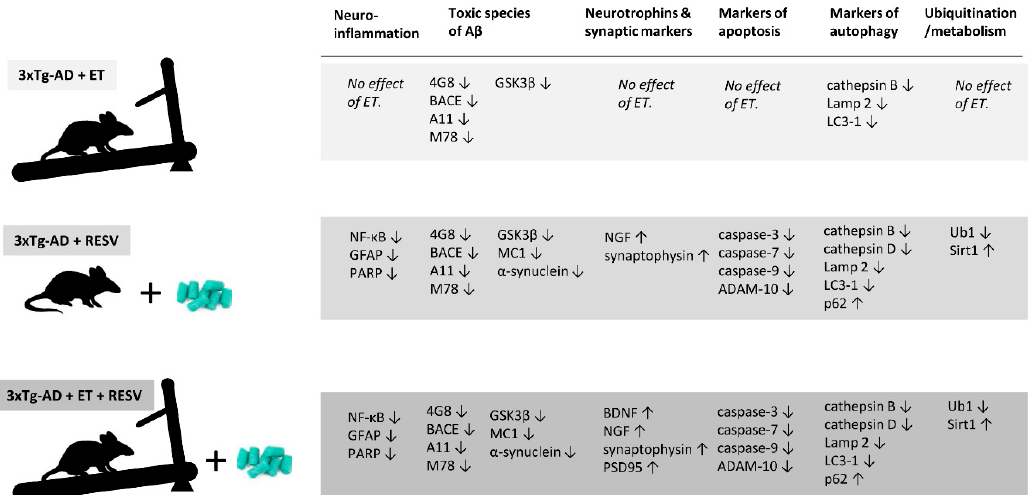
Figure 8. The effects of Resv and ET on protein expression of SIRT1 and AMPK. Representative immunoblots show a significant decrease in the expression level of SIRT1 in 3xTg-AD mice. Treatment with Resv or Resv with ET increased the expression SIRT1. Expression levels of AMPK were not significantly different between groups. Corresponding densitometry measurements: A, WT mice; B, 3xTg-AD mice; C, 3xTg-AD mice + ET; D, 3xTg-AD mice + Resv; E, 3xTg-AD mice + Resv + ET. SIRT1, silent information regulator 1; AMPK, AMP-activated protein kinase. AD, Alzheimer’s disease; ET, exercise training; Resv, resveratrol. Data presented as mean ± SEM for 3 mice per group. *, compared to WT mice, p < 0.05; † , compared to 3xTg-AD mice, p < 0.05; ‡ , compared to 3xTg-AD mice + ET, p < 0.05; # , p = 0.0578 compared to WT mice.